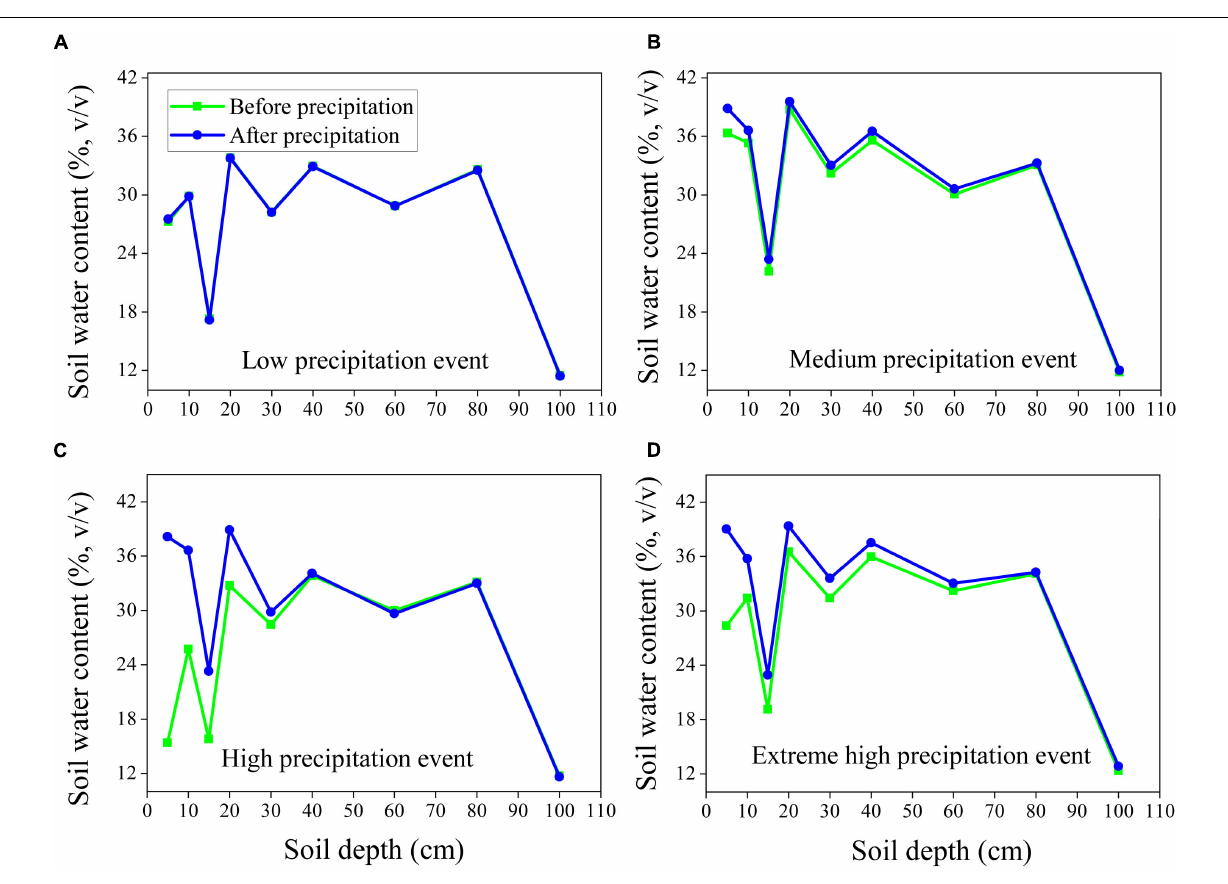
Frontiers in Plant Science |